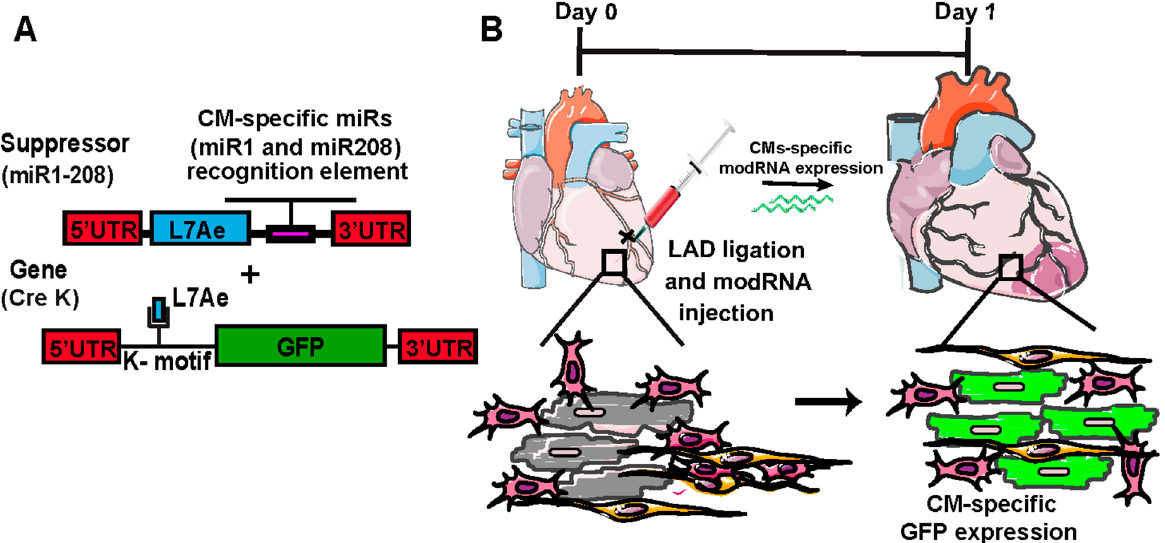
Figure 2. CM- and non-CM-specific modRNA expression platform. ( A ) Experimental design using two modRNA-based constructs to deliver any gene exclusively in CMs. ( B ) Schematic diagram showing CM-specific GFP modRNA expression in the mouse heart 1 day after MI and myocardial delivery of both modRNA constructs (Green wavy line represents modRNA which codes for gene of interest (GFP) would be delivered).